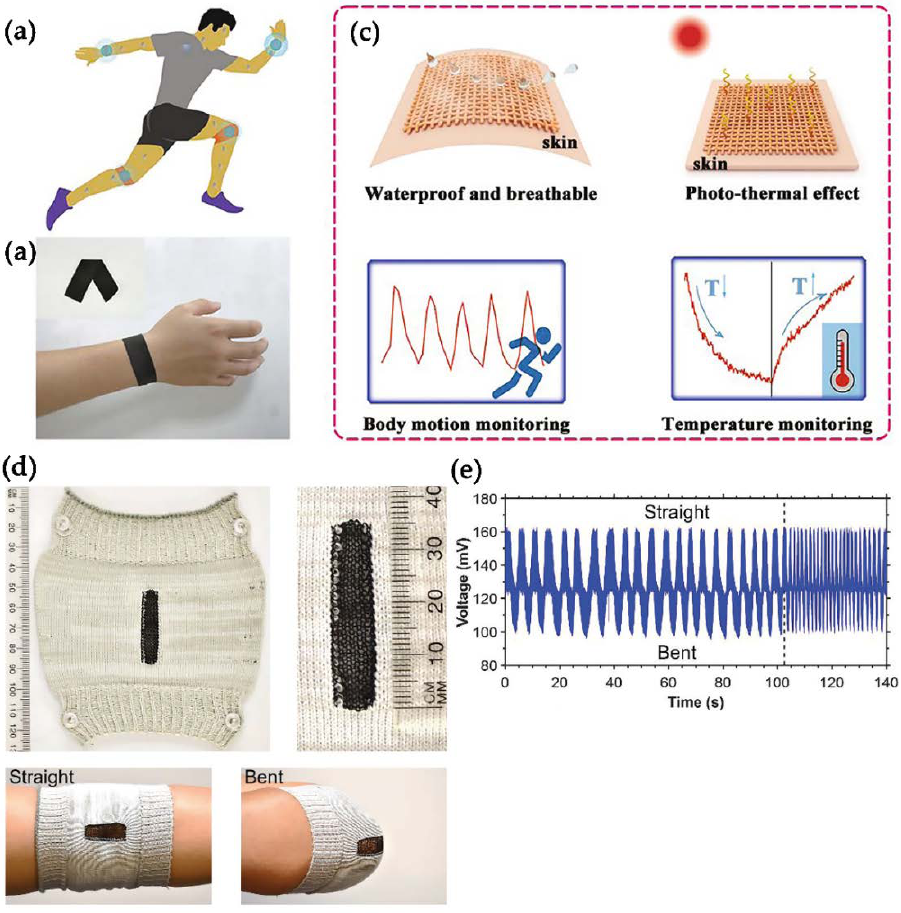
Figure 30. ( a ) Schematic illustration of the PM/PDMS textile attached to the joints of the human body to monitor motion actions. ( b ) A photograph of the volunteer wrist with MXene-based textile serving as a smart strain sensing device; the inset shows the photograph of one black ring textile. ( c ) Promising applications and superior properties. Reprinted with permission from [196] 2021 Elsevier. ( d ) One-piece sleeve for elbow knitted using four-ply yarn of Ti 3 C 2 T x MXene/polyurethane fiber in as-prepared and functioning states. ( e ) Strain sensing response of the elbow sleeve collected during continuous bending and straightening the elbow at two different frequencies (0.2 and 0.7 Hz) through a wireless Bluetooth connection. Reprinted with permission from [198] 2020 John Wiley and Sons.